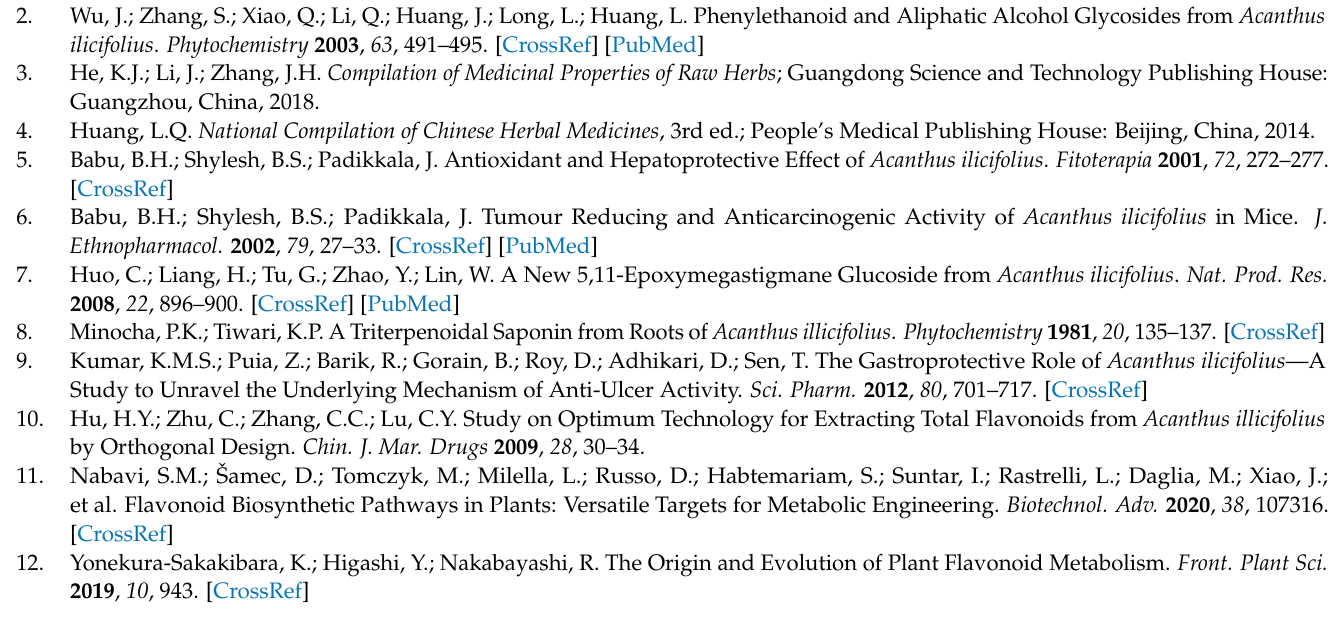
Table S1: Sequences of primers. Table S2: RNA sequencing data and quality control. Table S3: